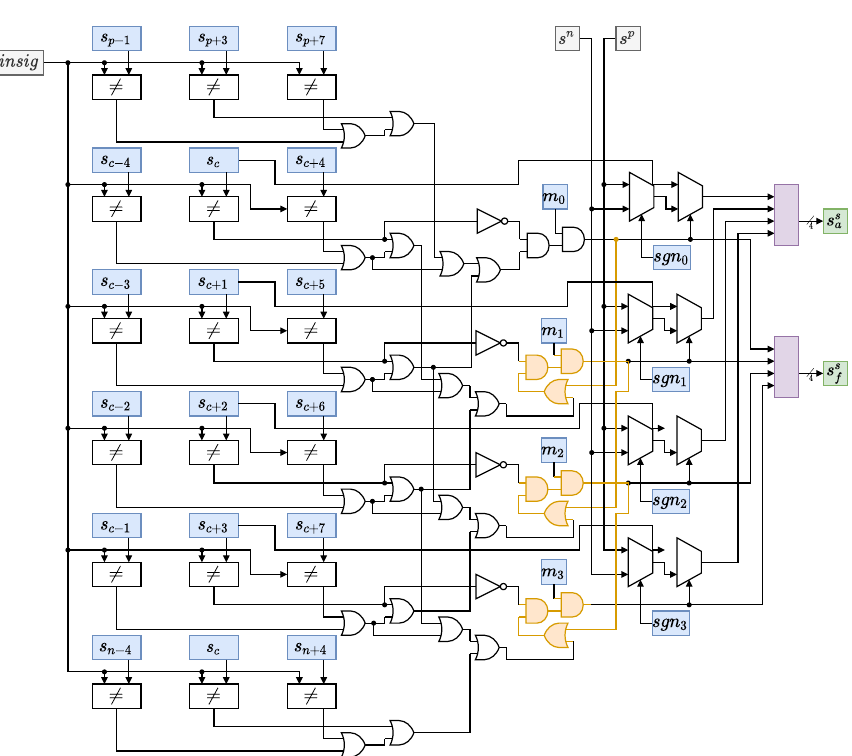
Figure 7. Significance predictor module. It cascades the possible significance conversion of all bits in the strip by using a small critical path, instead of waiting for the cascade of CG modules. The significances s , magnitude bits m , and sign bits sgn are used to produce the new significance s s a flag s s a , indicating if it is a newly acquired significance this cycle.